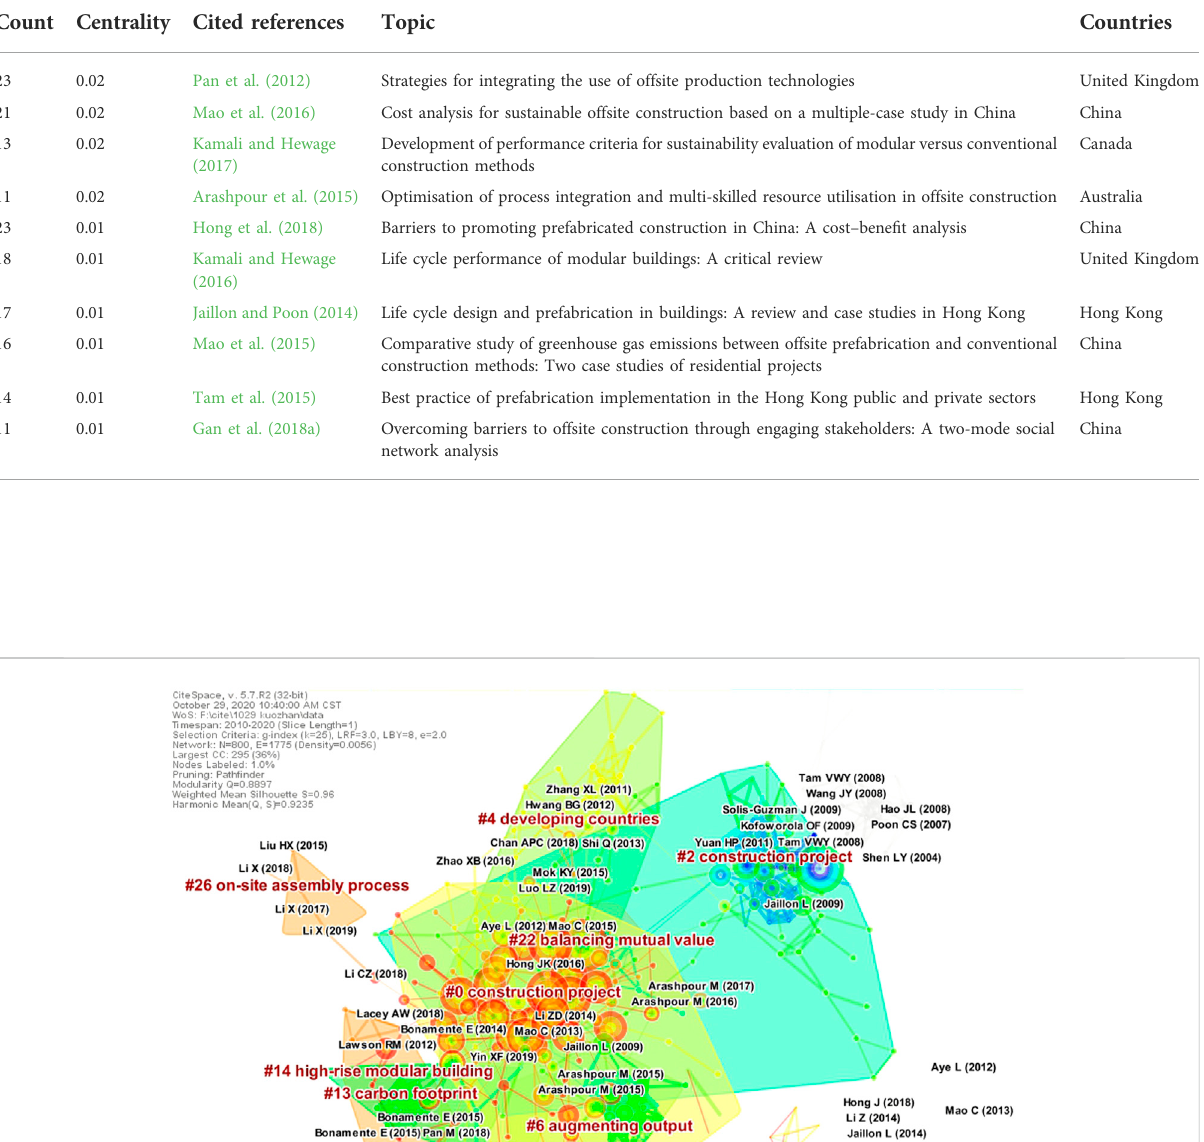
TABLE 6 Top 10 for the papers ’ reference co-cited analysis.